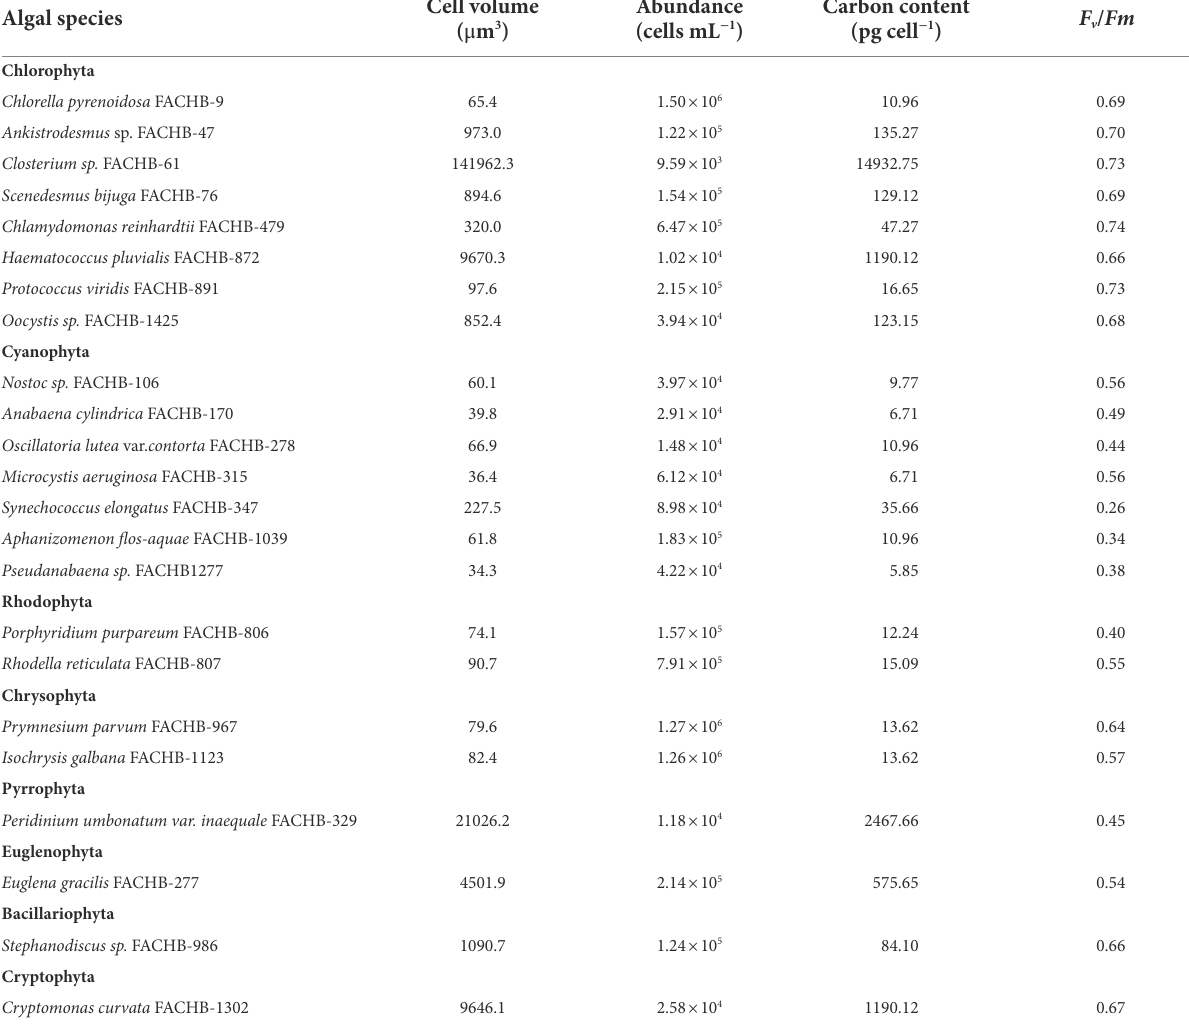
TABLE 1 Physiological parameters for 23 algal species at the exponential growth phase in normal culture experiment in this study. Algal